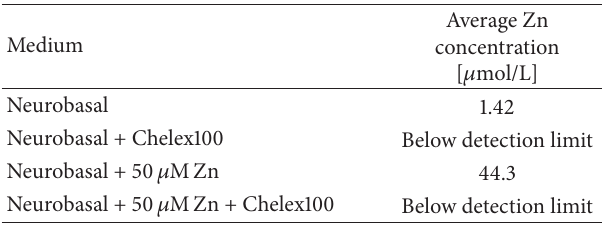
Table 1: Depletion of divalent metal ions by Chelex 100 purification of growth media. Chelex chelating ion exchange resin has high preference for copper, iron, zinc, and other divalent heavy metals over monovalent cations such as sodium and potassium with a selectivity for divalent over monovalent ions of approximately 5,000 to 1. To control the efficacy of ion chelation, the Zn concentration of Neurobasal medium was measured by ICP-MS, before and after application of Chelex. Additionally, the growth medium was sup- and subsequently subjected to metal plemented with 50 𝜇 MZnCl 2 depletion. In both cases, Zn levels dropped below the detection limit after purification of the media by Chelex